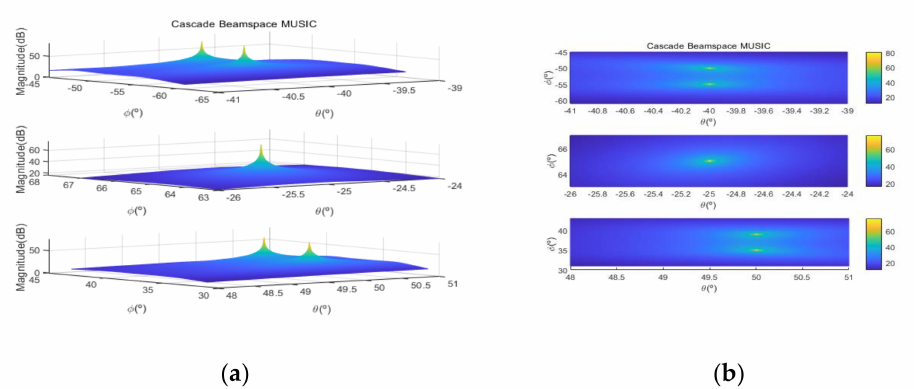
Figure 17. Spatial spectrum of Beamspace MUSIC in the proposed algorithm, for the fourth scenario: ( a ) 3D, ( b ) top view ( θ 1 = − 41 ◦ ∼− 39 ◦ , φ 1 = − 61 ◦ ∼− 45 ◦ , θ 2 = − 26 ◦ ∼− 24 ◦ , φ 2 = 63 ◦ ∼ 67 ◦ , θ 3 = 48 ◦ ∼ 51 ◦ , φ = 31 ◦ ∼ 43 ◦ ). 3